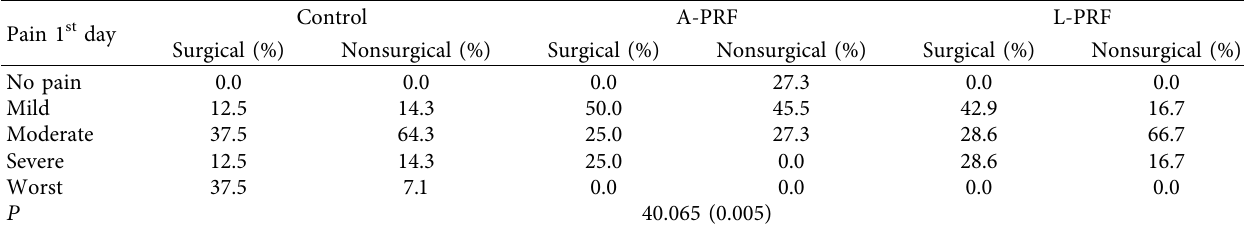
Table 1: The visual analogue scale pain scores of each group on the first day after tooth extraction.